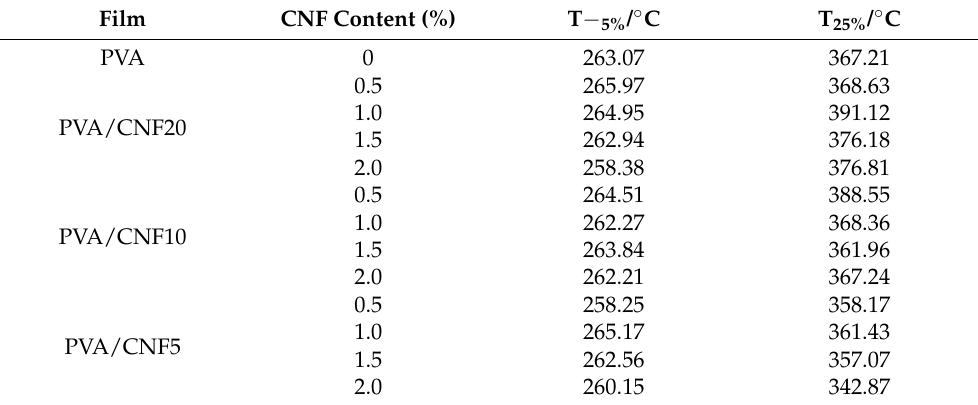
Table 3. The TGA data of neat PVA and PVA/CNF composites as a function of the CNF